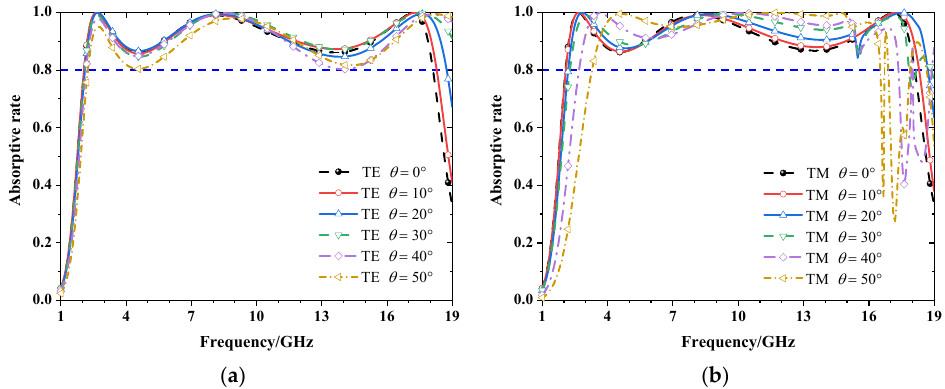
Figure 6. The absorptive rate at different oblique angles under ( a ) TE and ( b ) TM polarization.